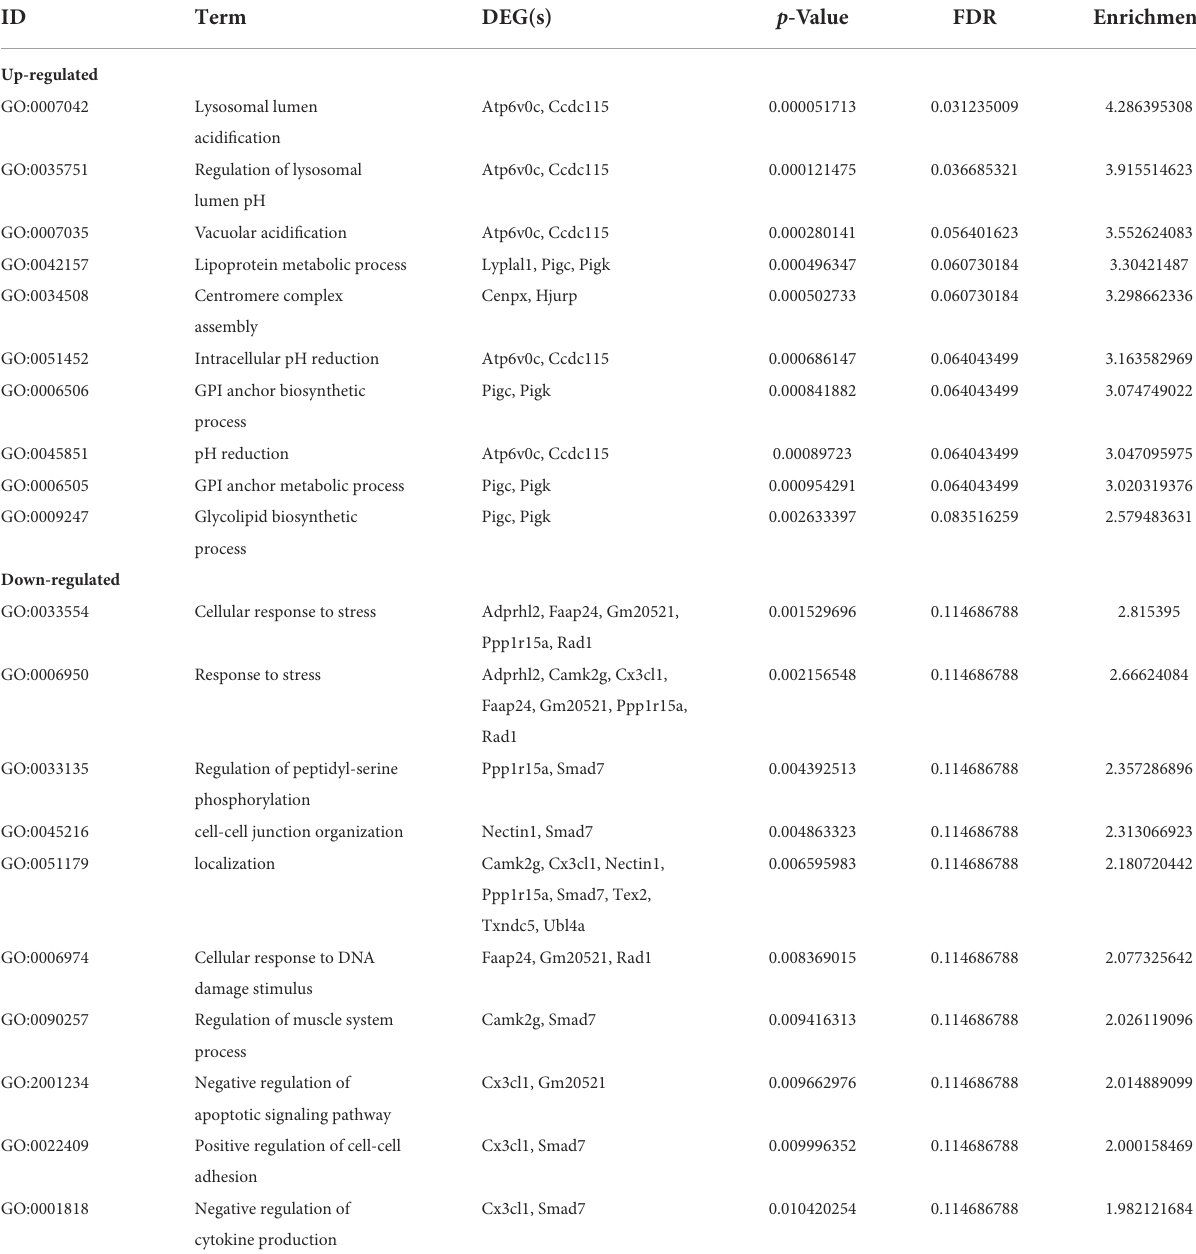
TABLE 2 Top 10 enriched BP terms of up-regulated and down-regulated